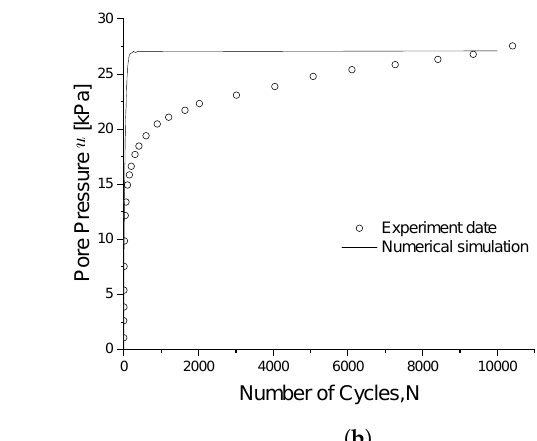
Figure 15. Experimental-numerical comparison of ( a ) axial strain and ( b ) pore pressure evolutions for WenZhou